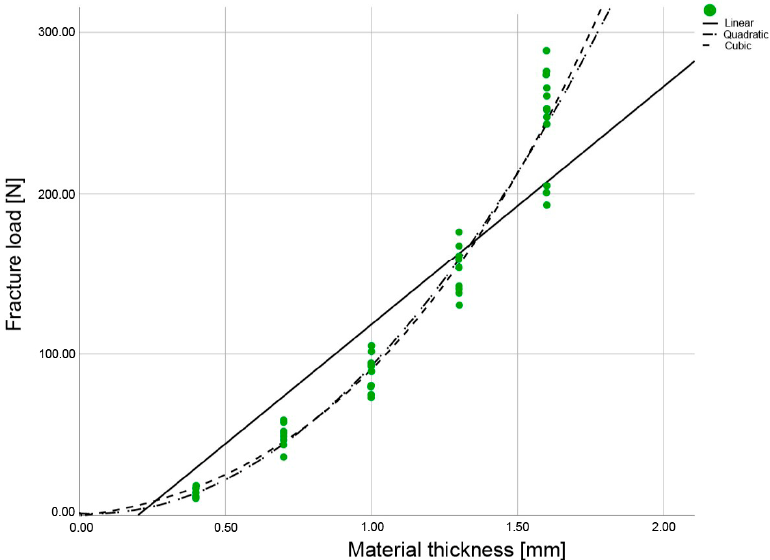
Figure 4. Regression curves of the fracture load values for the IPS Empress CAD LT A2 (ESS), with specimens in the five different material thicknesses examined.